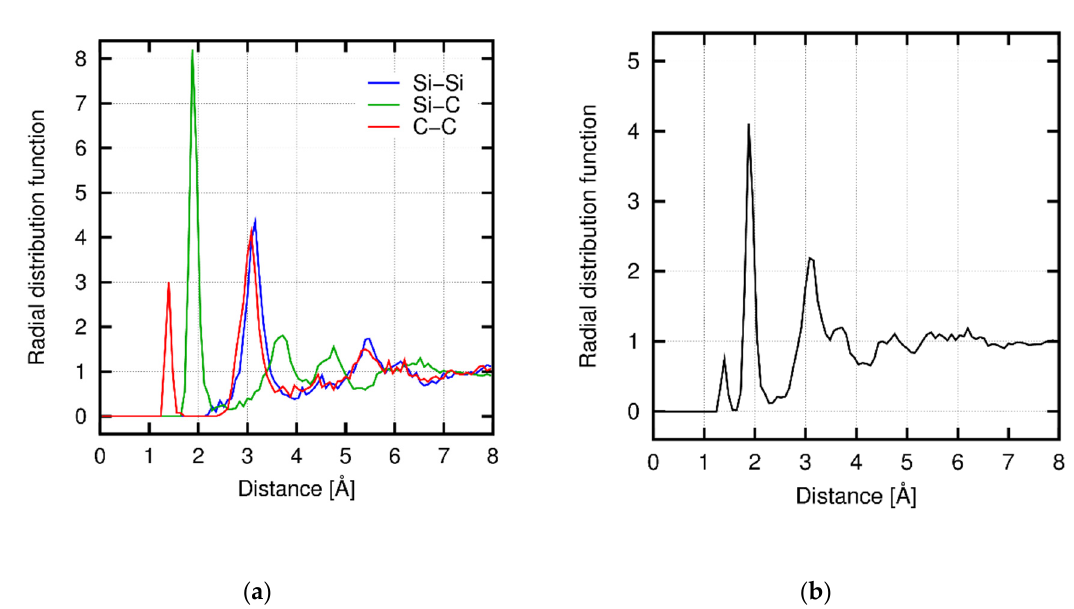
Figure 5. Radial distribution functions (RDFs) of amorphous SiC where ( a ) each contribution is shown separately, and ( b ) all combinations are included. All the RDFs are normalized by the global number density of atoms (regarding the corresponding pair type) and thus converge to 1 with the distance r → ∞ .